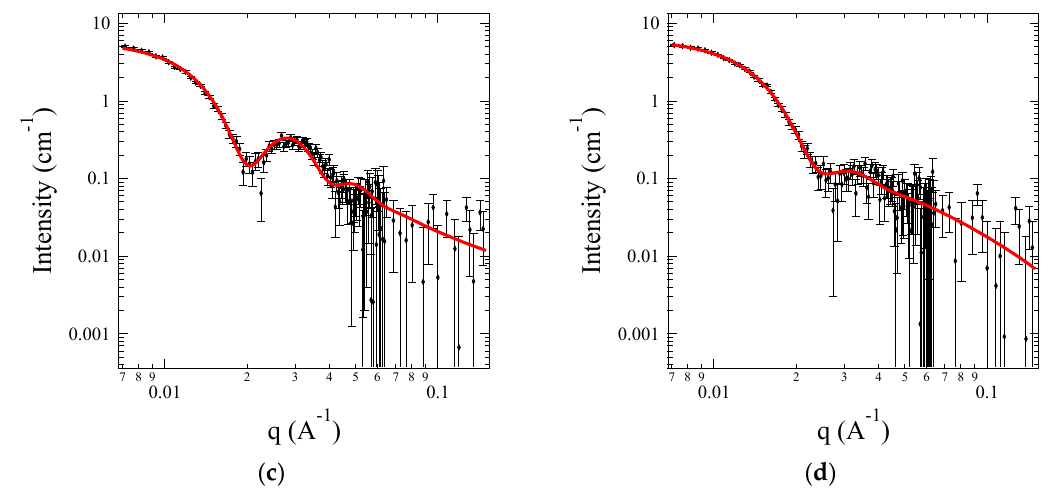
Figure 6. SANS profiles 0.5 wt % C3Ms for ( a ) A + S; ( b ) A + C; ( c ) G + S and ( d ) G + C using dOA block copolymers under the corona contrast system. The symbols are the SANS data, and the solid lines are the model equation fits. Table 3. SANS fitting result of corona contrast system.